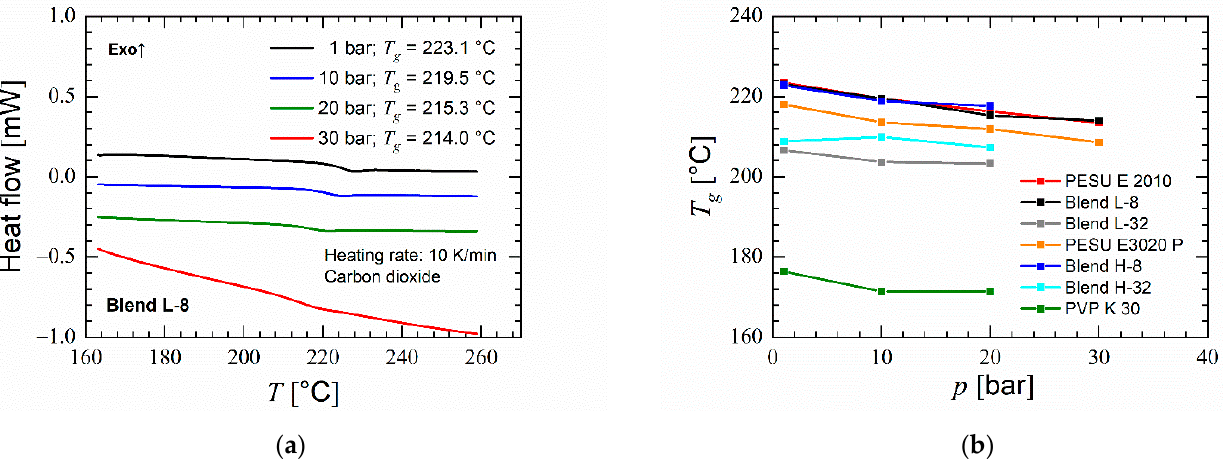
Figure 4. HP-DSC results for selected blends: ( a ) Effect of CO 2 pressure on glass transition temperature of blend L-8 ( b ) T g at various CO 2 pressures (Some materials did not show an identifiable glass transition at 30 bar).